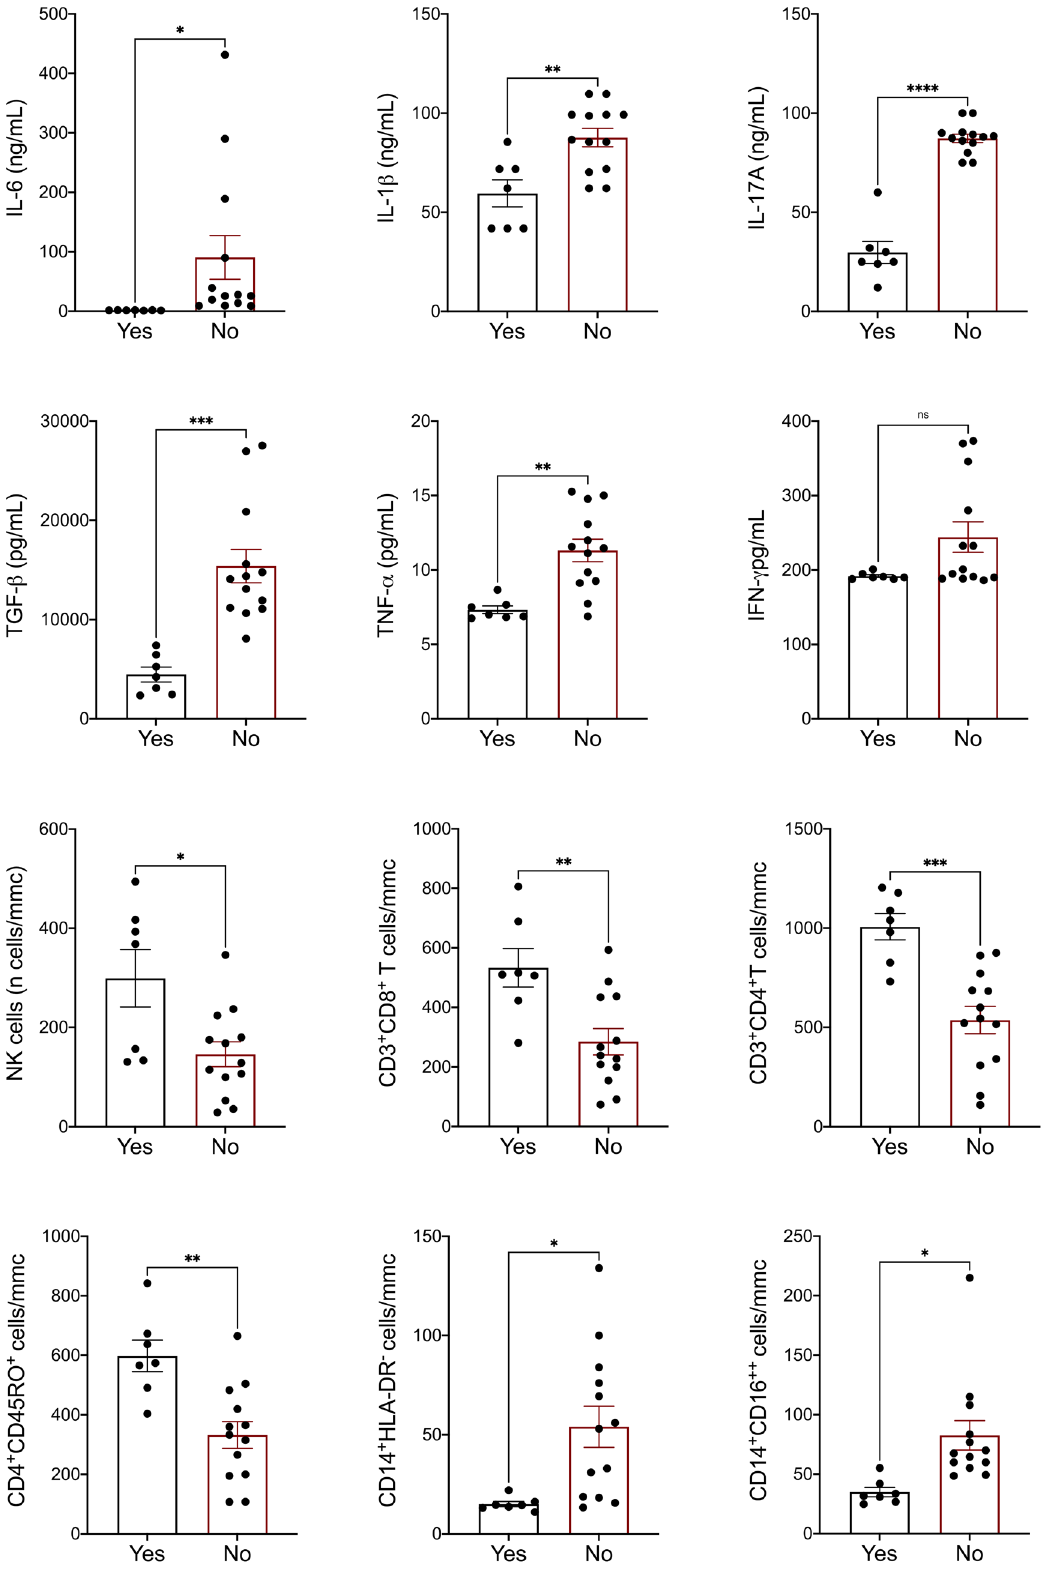
Figure 5. Immune dysregulation at baseline and achievement of viral clearance by 28 days. Amount of circulating cytokines and absolute counts of immune cells in peripheral blood of COVID-19 patienst at hospital admission, distinguished on the achievement of viral clearance by 28 days. Color code: black (patients who achieved viral clearance by 28 days, N = 7); red (patients who did not achieve viral clearance by 28 days, N = 13). Viral clearance was defined as two consecutive negative nasal-pharyngeal swabs. Bars represent mean and standard deviation among the two groups; significance was assessed by T-student test for unpaired samples, *p < 0.005, **p < 0.001, ***p <